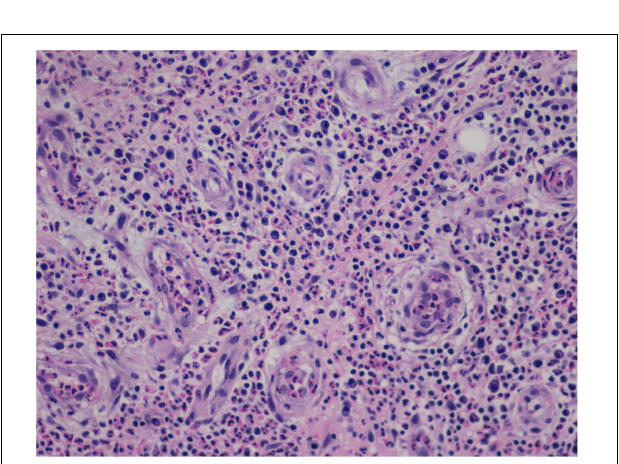
FIGURE 7 | “Extranodal natural killer/T-cell lymphoma, nasal type-orbital-cerebral mycosis.” Mucor irregularis- induced atypical hyperplasia (H&E, original magnification ×